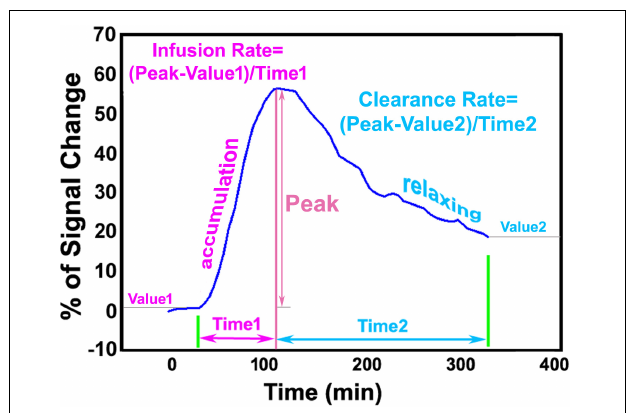
FIGURE 1 | Representative time signal curve (TSC) of a tissue cluster, illustrating infusion rate and clearance rate obtained from accumulation phase and relaxing phase,